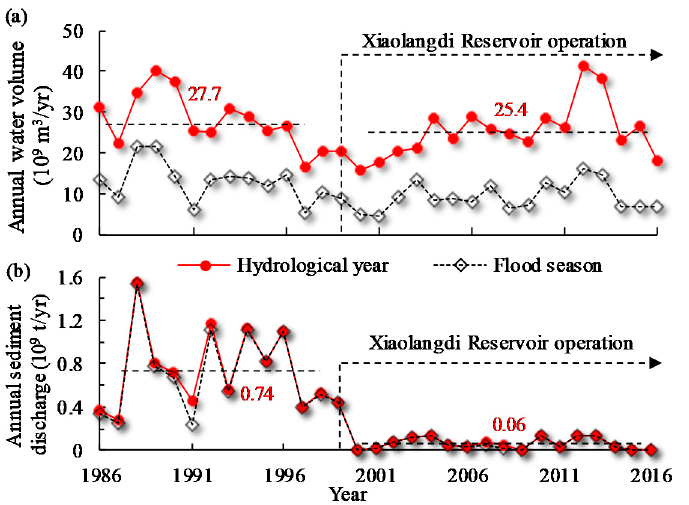
Figure 2. Variation in the condition of flow and sediment at HYK: ( a ) water volume; ( b ) sediment discharge.